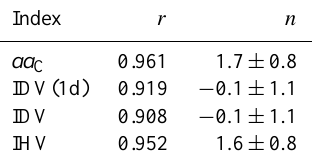
Table 1. The peak linear correlation coefficients, r , and the opti- mum n values for the geomagnetic indices with BV n riod 1966–2012, inclusive. In all cases the correlation significance level exceeds the (1–10 − 5 ) level. The errors in the n values are at the 1.65 σ level; i.e. there are where the correlation is lower than at the peak by a difference that is significant at the 90%